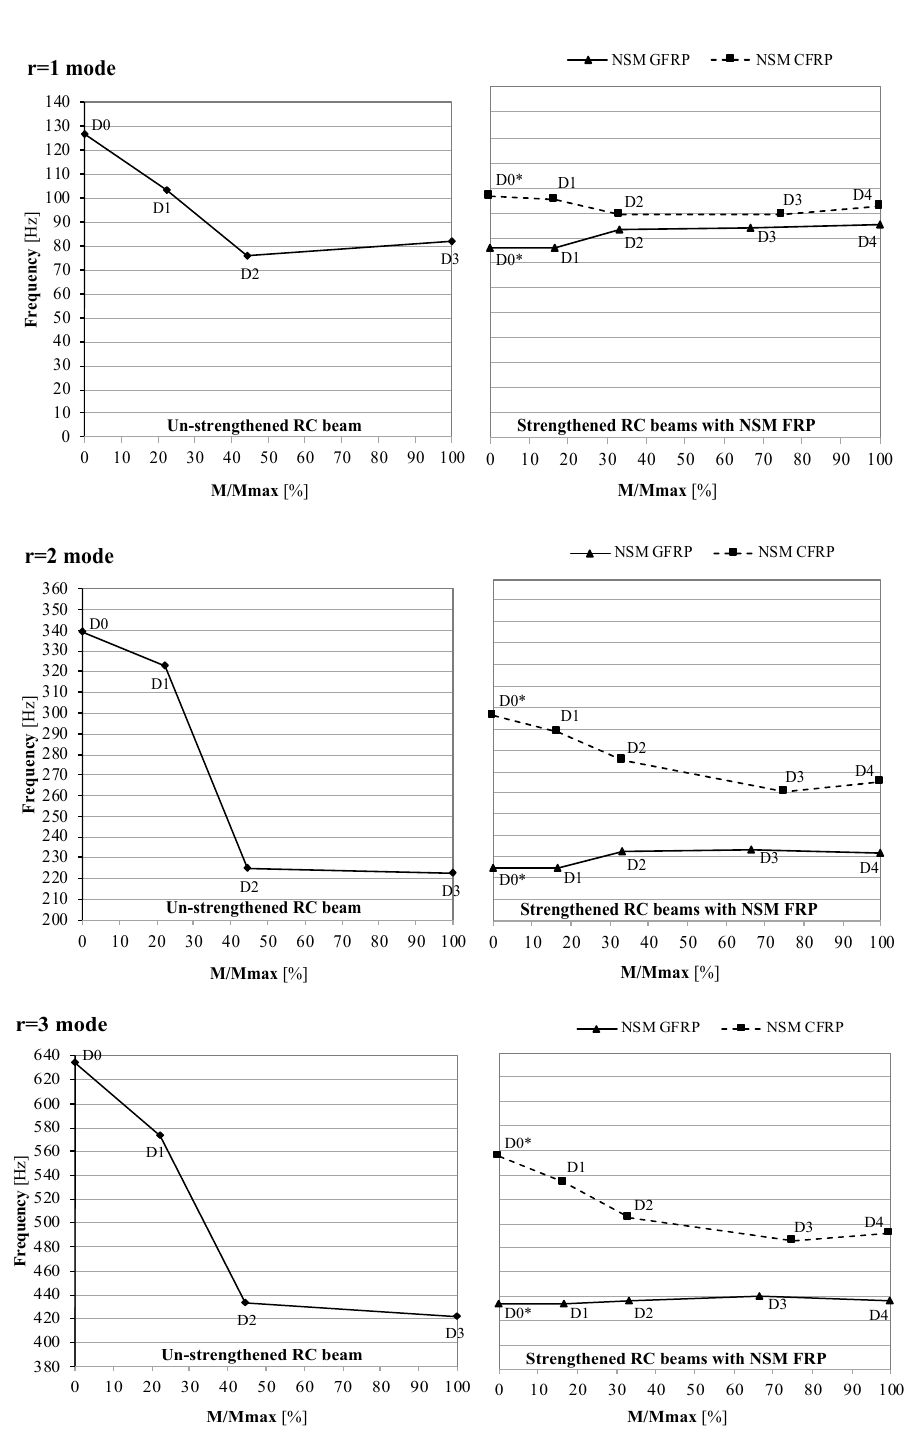
Figure 16. Exp. diagrams of frequency values for the first 3 modes r = 1, 2, 3 vs. moment ratio M/M max (%).